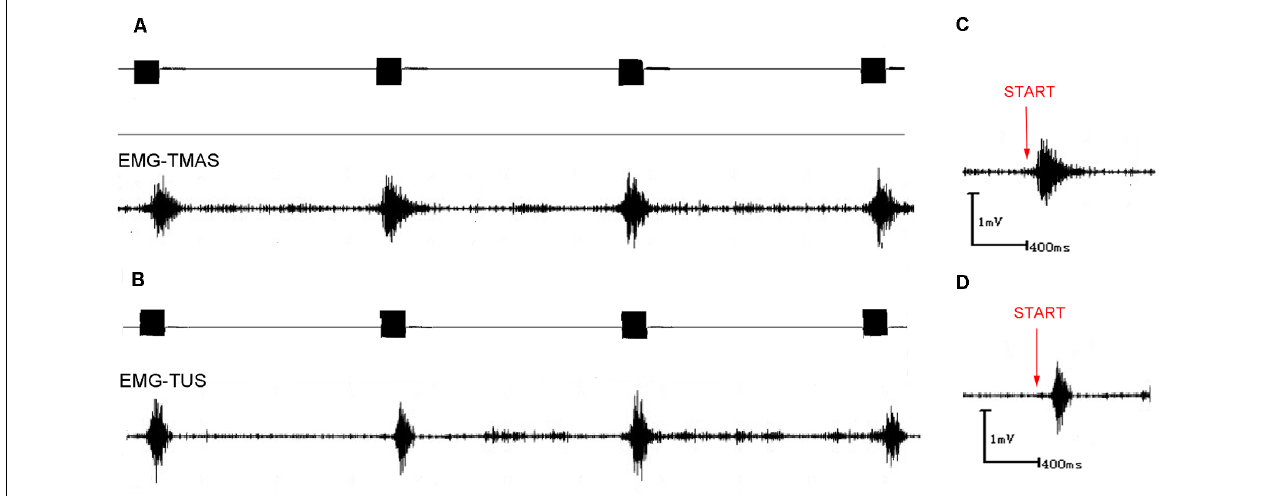
FIGURE 5 | EMG signals induced by TUS and TMAS. (A) EMG signal induced by TMAS. Ultrasonic excitation signal (top; 500 kHz, 300 pulses, 1 kHz PRF, 400 NTB, T = 4 s); induced synchronous, stable EMG signal (bottom). (B) EMG signal induced by TUS. Ultrasonic excitation signal (top; 500 kHz, 300 pulses, 1 kHz PRF, 400 NTB, T = 4 s); induced synchronous, stable EMG signal (bottom). (C) EMG signal induced by TMAS. Start (red) represents the starting point of the TMAS stimulation. (D) EMG signal induced by TUS. Start (red) represents the starting point of the TUS stimulation.